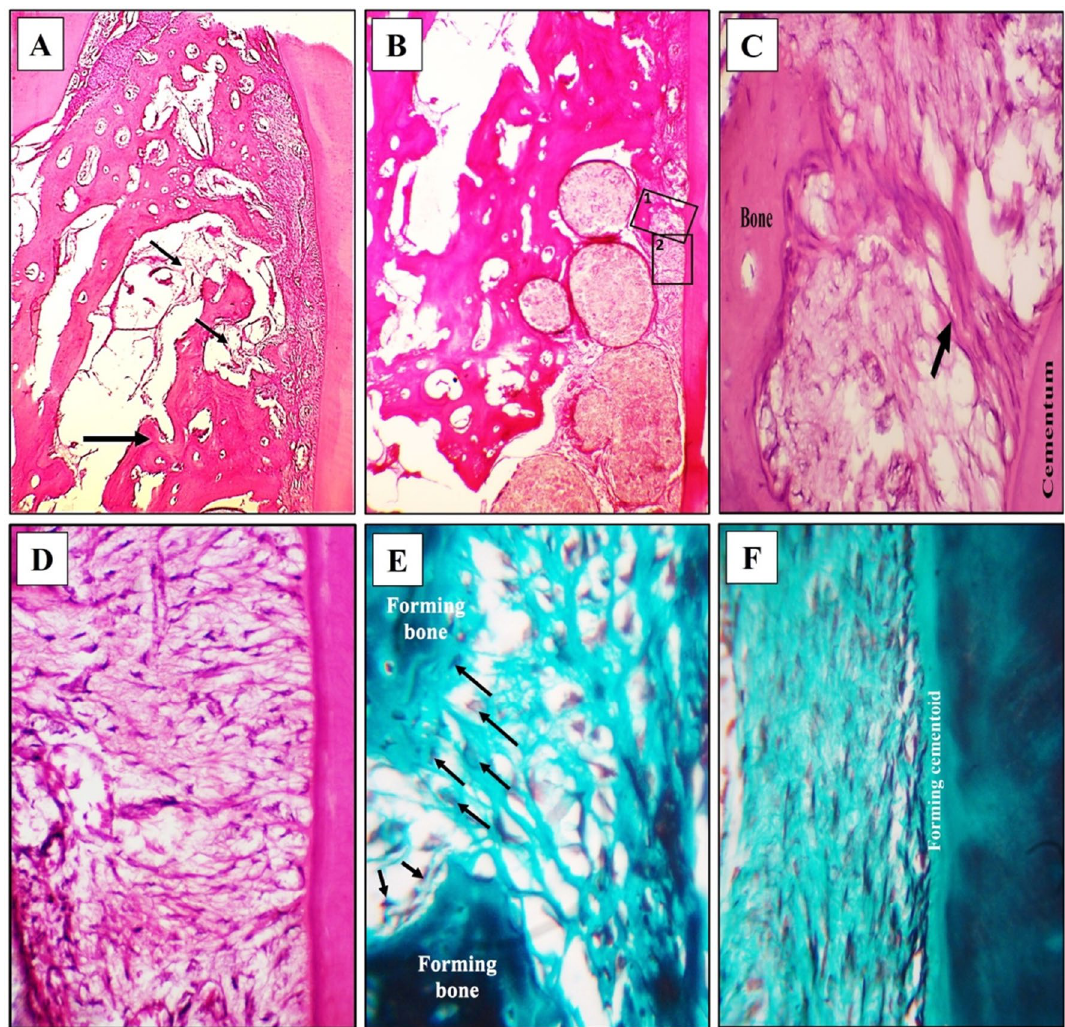
Figure 5. Control group at 8 weeks observational period (A) Prevalence of bone formation at the sides and coronal parts of the defect. Some remanent of β-TCP particles is seen in the areas devoid of bone formation (thin arrows). PDL fibers are seen along one side of the regenerating defect, H&E, 40×. (B) Part of the regenerating defect just apical to the level of the thick arrow in the previous figure revealing part of the formed bone and aggregates of β-TCP between it and the PDL, H&E, original magnification 100×. (C) Disorganized PDL fibers and cells with the appearance of a fiber bundle exhibiting disorganized thickness and course towards the forming bone (arrow), H&E, 400×. (D) interrupted thin PDL fibers and disorganized orientation of the fibroblast cells, Note the inconsistent fiber insertion in cementum H&E, 400×. ( E) Irregularly organized fibers and osteoblasts at the border of the formed bone and between the inserting fibers (arrows), Trichrome stain, 400×. (F) Irregularly organized cementoblasts adjacent to cementum, Trichrome stain,